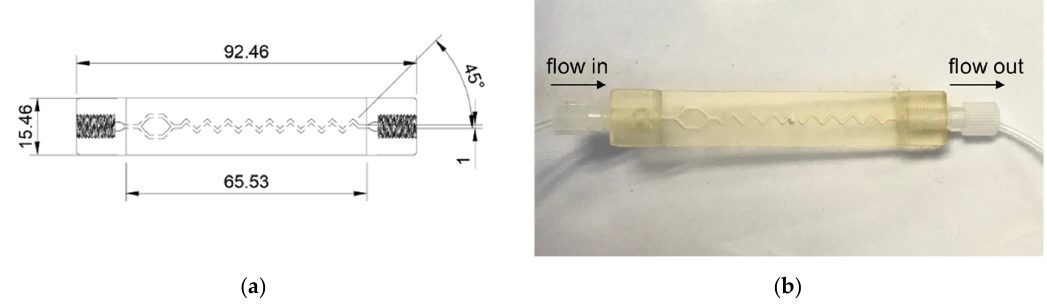
Figure 7. 3D ‐ printed mixing channel: ( a ) CAD design; ( b ) photograph of a mixing channel.